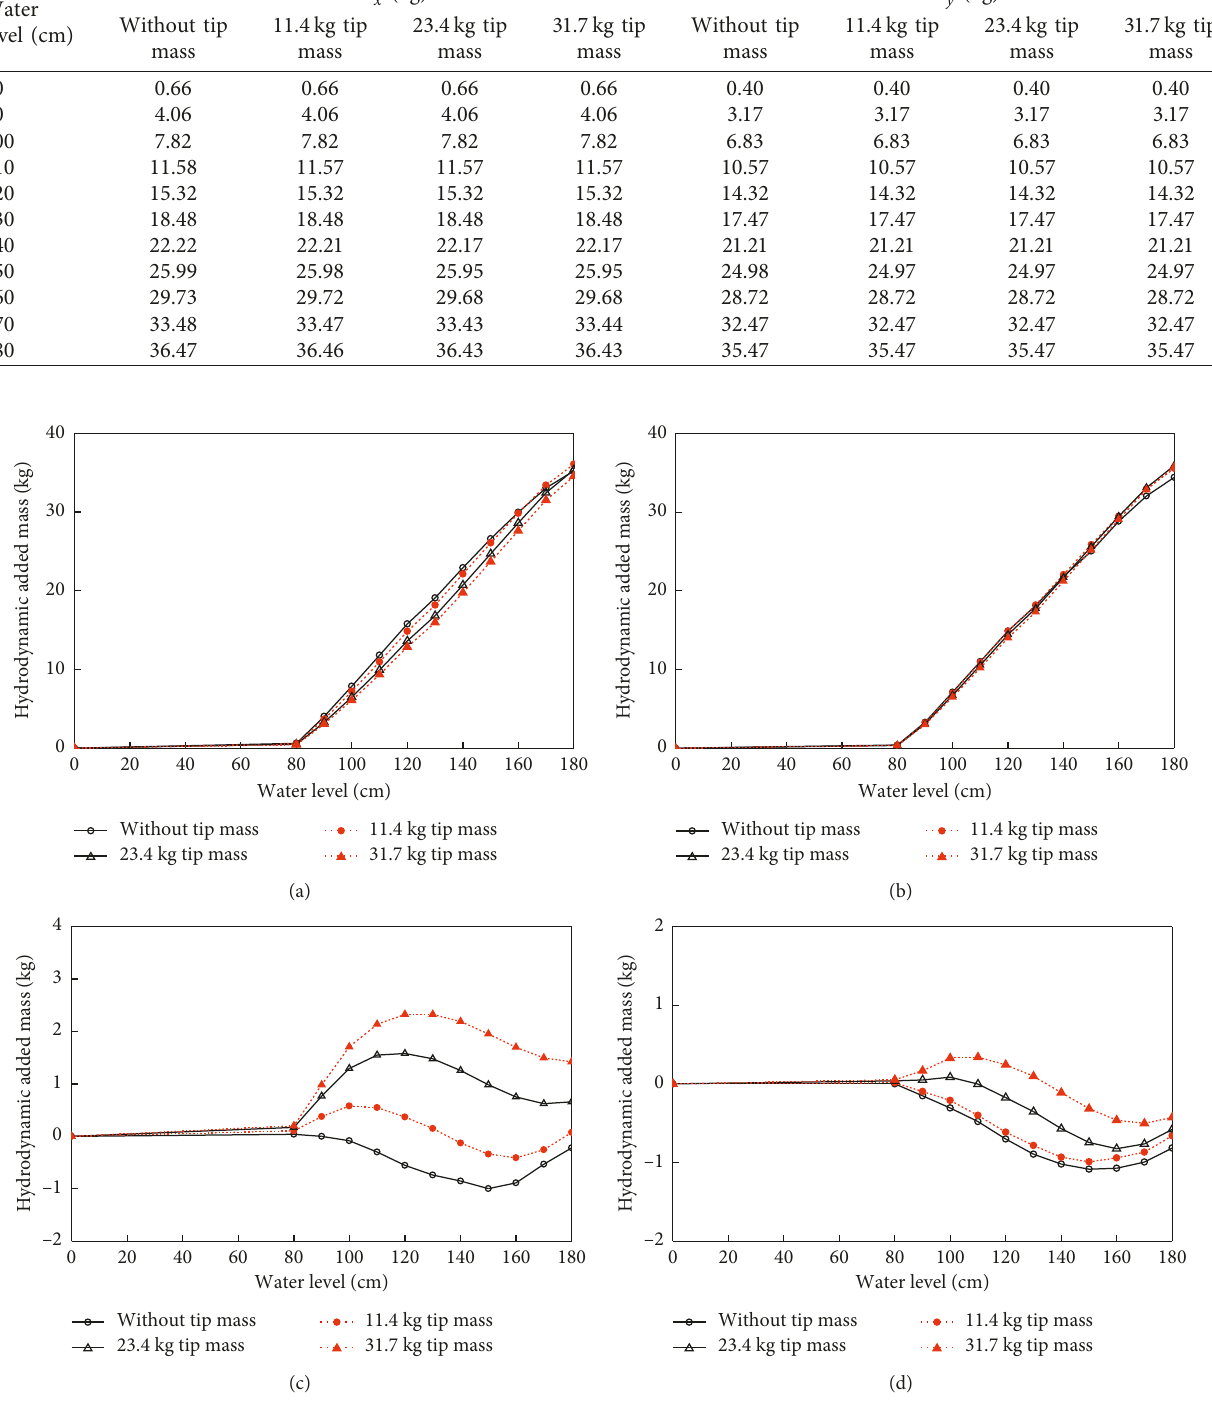
Figure 11: MHAM of the specimen for the four tip masses in case II as a function of water level, corresponding to (a) first mode along the x -axis; (b) first mode along the y -axis; (c) second mode along the x -axis; and (d) second mode along the y -axis.